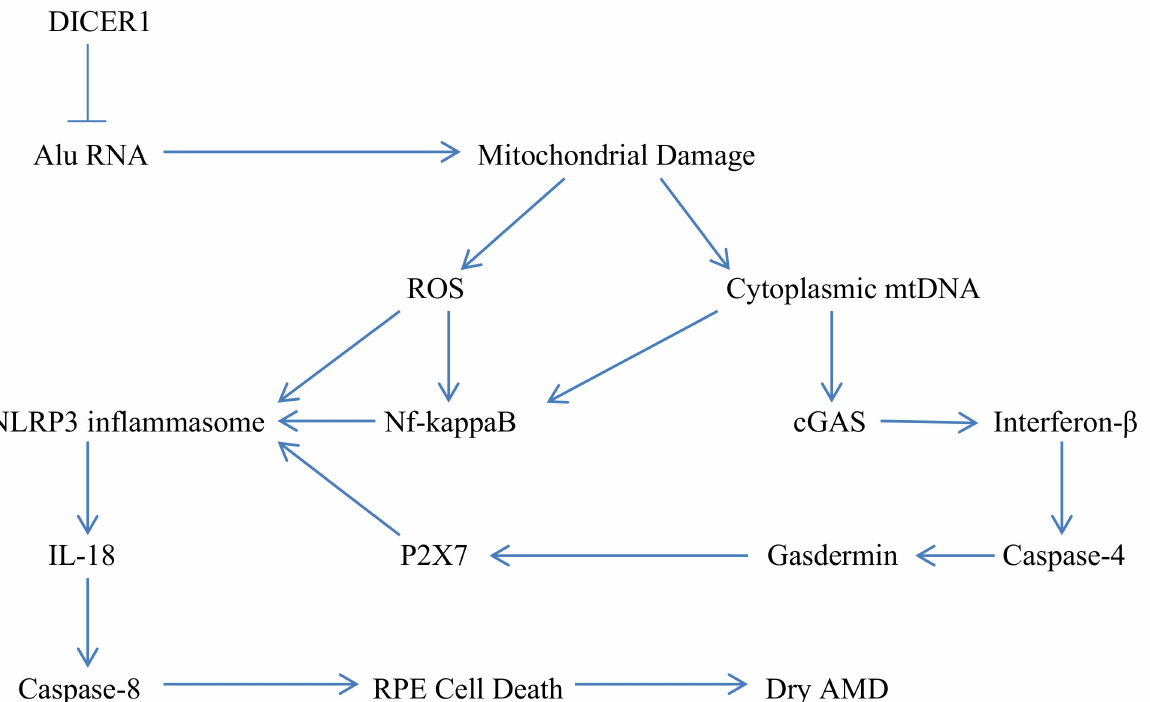
Figure 1. A simplified depiction of how DICER1 deficiency in RPE cells leads to Alu RNA excess, mitochondrial damage, NLRP3 inflammasome activation, autocrine IL-18 activity, and caspase-8- mediated cell